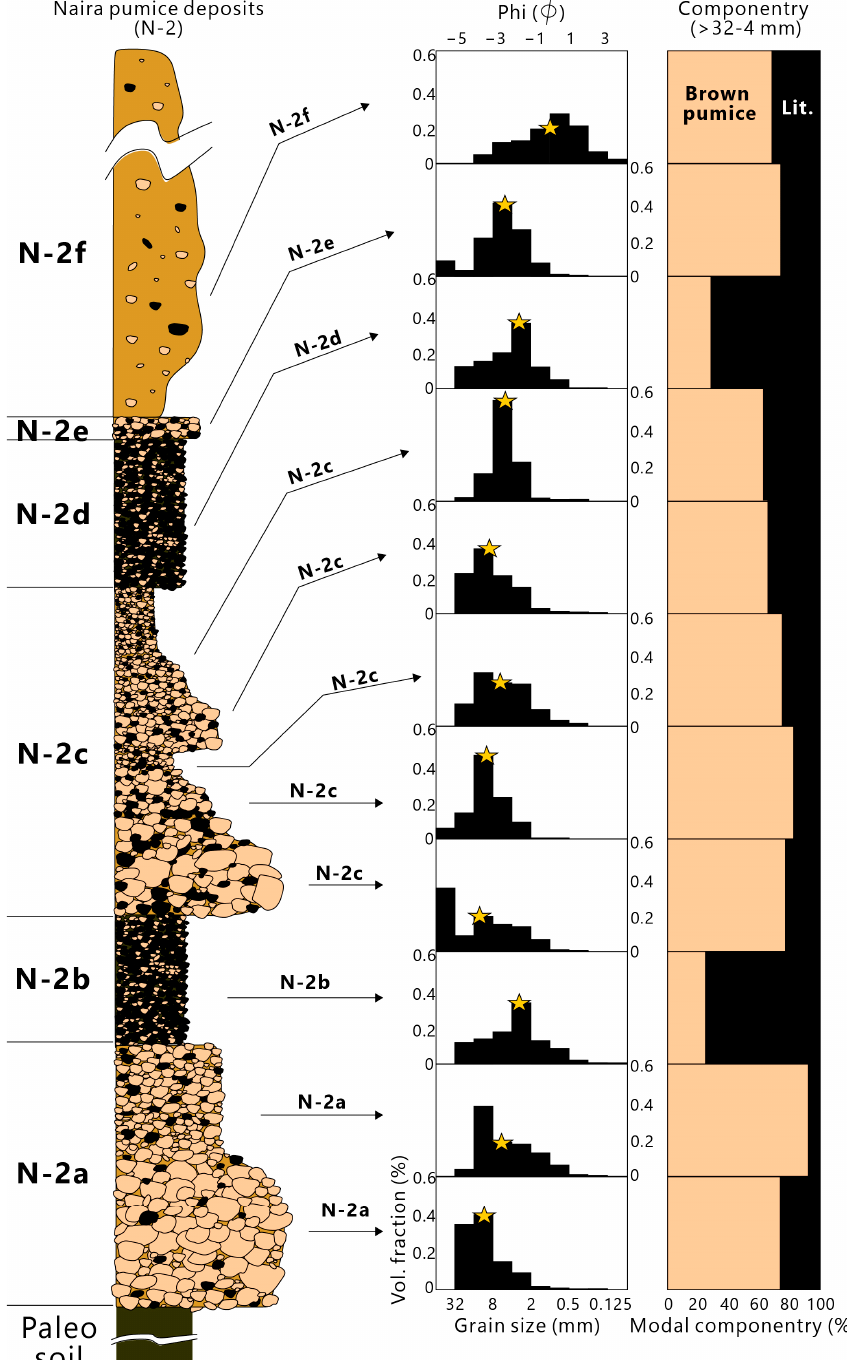
Figure 8. Composite stratigraphy, grain size distributions (GSDs), and componentry result of the Naira pumice deposits (N-2). Star symbols in GSD histograms represent the median size. Brown and black colors in componentry represent brown pumice and lithics.